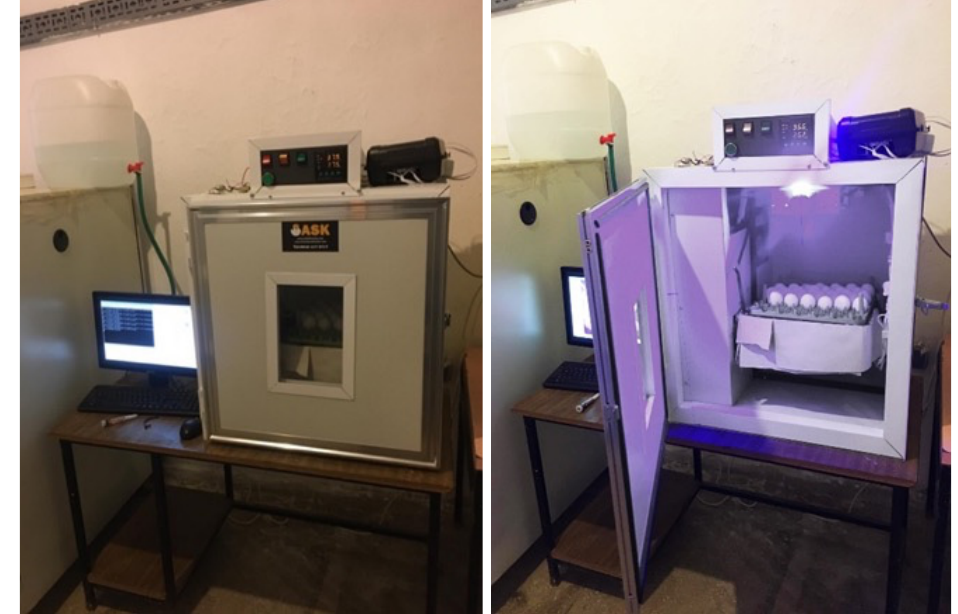
Figure 2. General view of the image acquisition and incubation